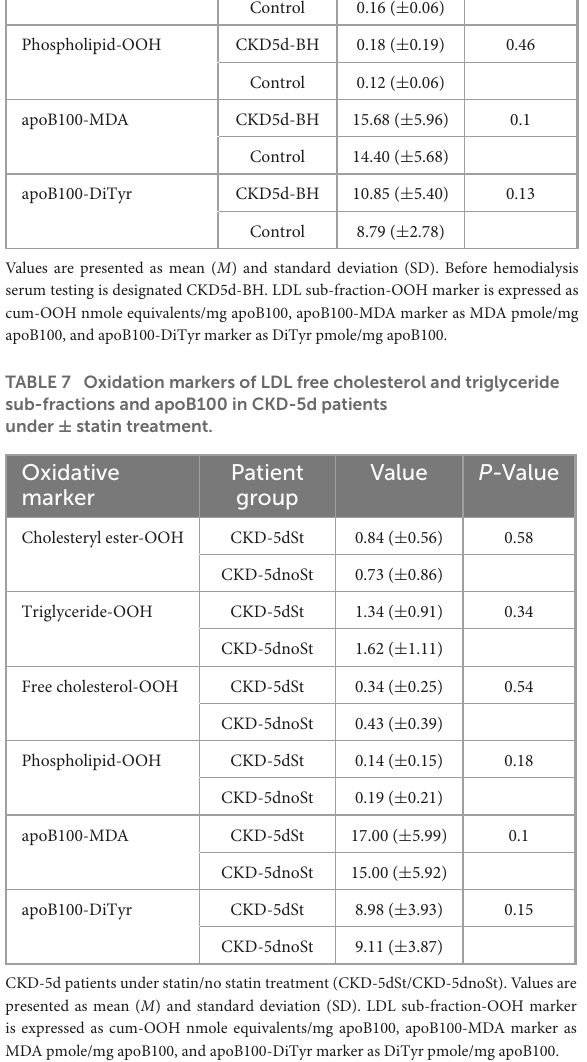
markers, using Simple Linear Regression analysis. The statistical analysis shows that years of hemodialysis do not correlate with triglyceride-OOH levels ( β = 0.05, t = 1.85, p = 0.07), since years of hemodialysis explain 4% of the variance [ R 2 = 0.04, F (1,59) = 3.42, p = 0.07]. Similarly, there is no statistically significant correlation of years of hemodialysis with the levels of free cholesterol-OOH ( β = 0.006, t = 0.60, p = 0.55), since years of hemodialysis explain only 1% of the variance [ R 2 =